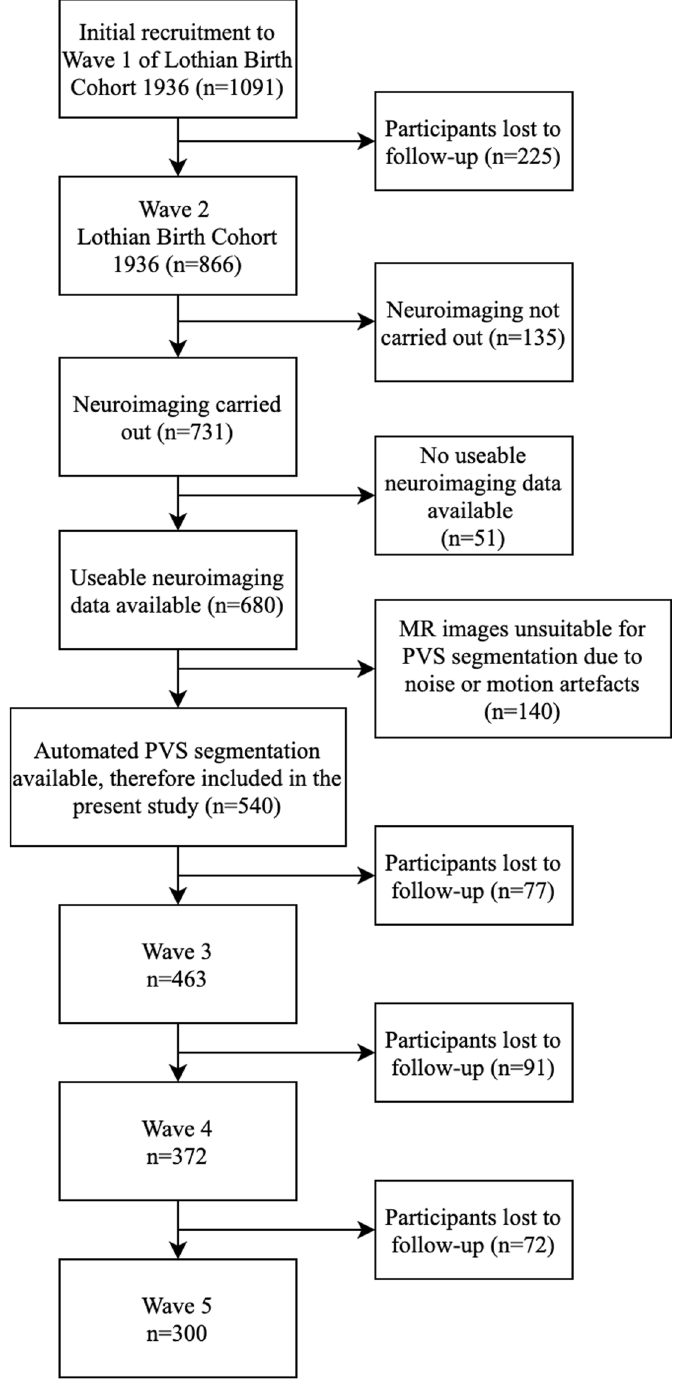
Fig. 2 Consort diagram illustrating the selection of the study cognitive test load onto superordinate latent intercepts and latent slopes of their respective cognitive domains (see Fig. 3A). This permits analysis of the initial level and trajectory of each cognitive domain as if they were directly observed. Hierarchical factor-of-curves models of S VD-cognitive ability associations Next, we speci fi ed linear regressions between baseline (Wave 2) SVD burden (independent variable) and the latent intercepts and